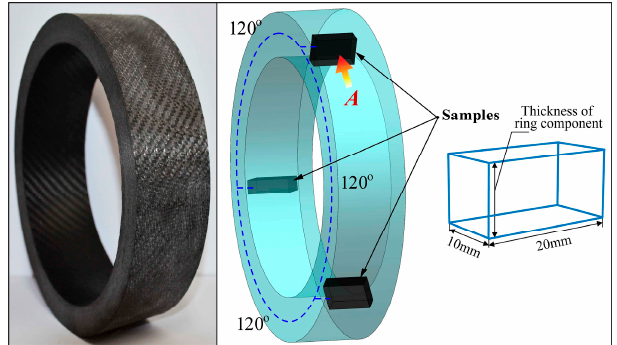
Figure 4. Sketch map of cutting the samples for void content testing.